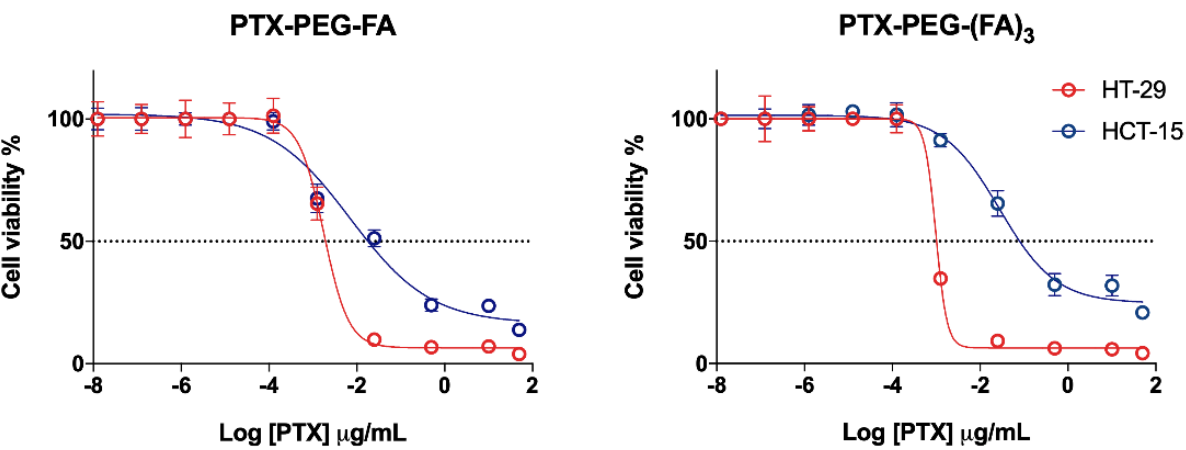
Figure 4. Graphical comparison between the cytotoxicity of the two targeted conjugates in FR-positive (red) and FR-negative (blue) cells. Table 3. IC 50 values (ng/mL PTX).